Question: Sum up the contents of this chart in one sentence.
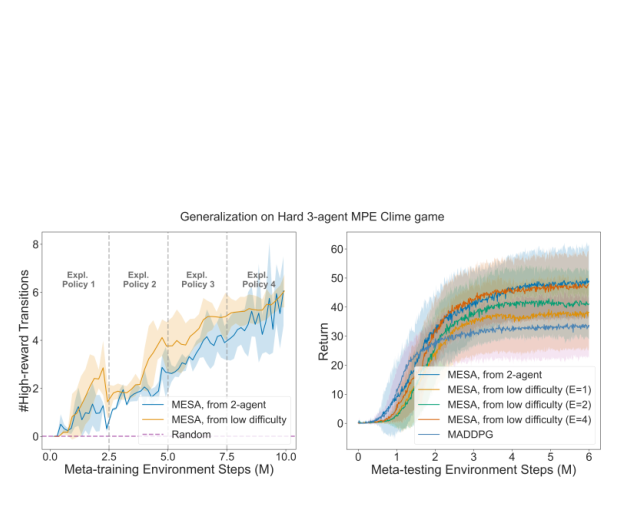
Answer: Generalization results of MESA on the hard 3-agent MPE Climb game. Left: Zero-shot generalizability of the meta-exploration policies, measured by the number of vis- itations on high-reward transitions per episode on the test tasks. The purple dotted line corresponds to the random ex- ploration policy. The plot shows the concatenated training curves for all exploration policies. Right: Learning curves of MESA under diﬀerent settings using the meta-exploration policies trained on the two diﬀerent training-task distribu- tions.